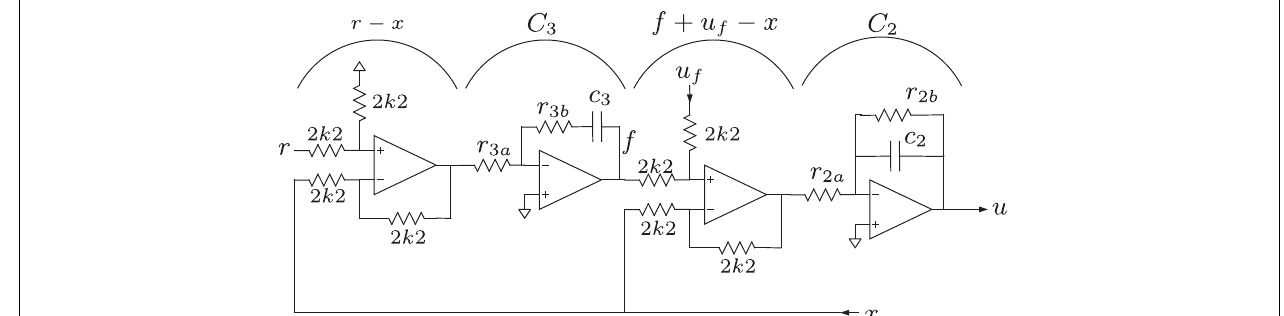
FIGURE 10 | Analog implementation of an IRC damping and PI tracking controller .